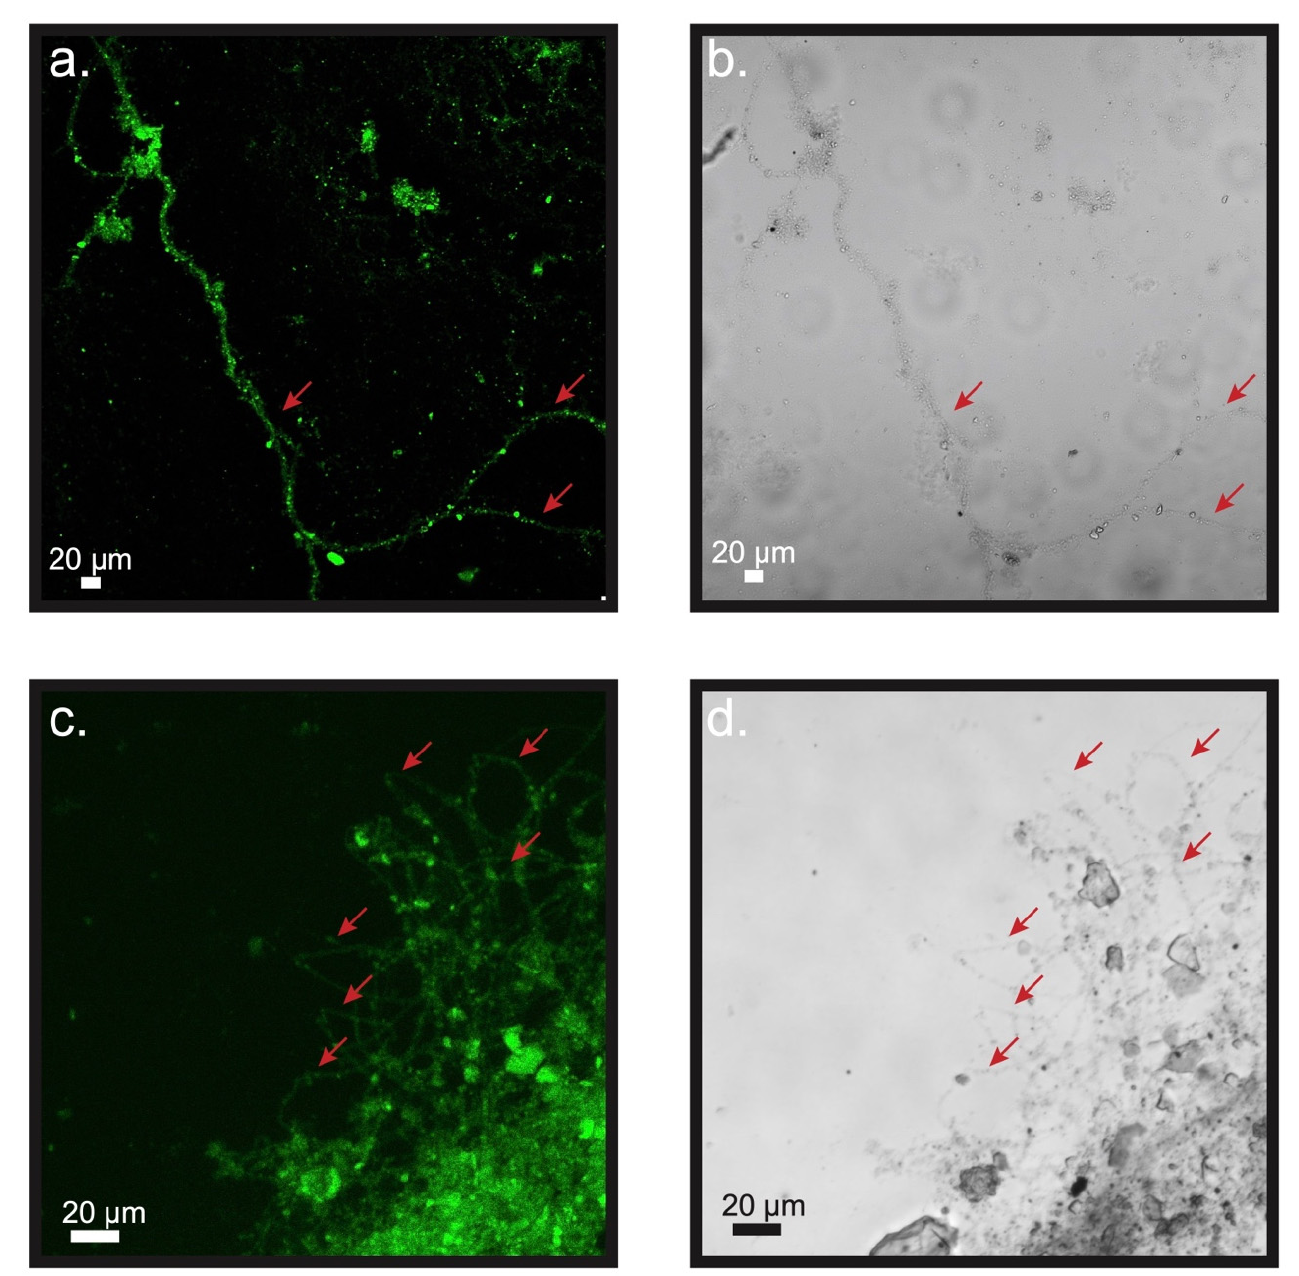
Figure 7. Filaments belonging to Desulfobulbaceae extracted from the uppermost sediment inside reactor A after 184 days of cultivation in ( a ) Alexa Fluor 488 and ( b ) bright field images; filaments belonging to Desulfobulbaceae extracted from the uppermost sediment inside reactor B after 184 days of cultivation in ( c ) Alexa Fluor 488 and ( d ) bright field images. Red arrows indicate the locations of filaments.